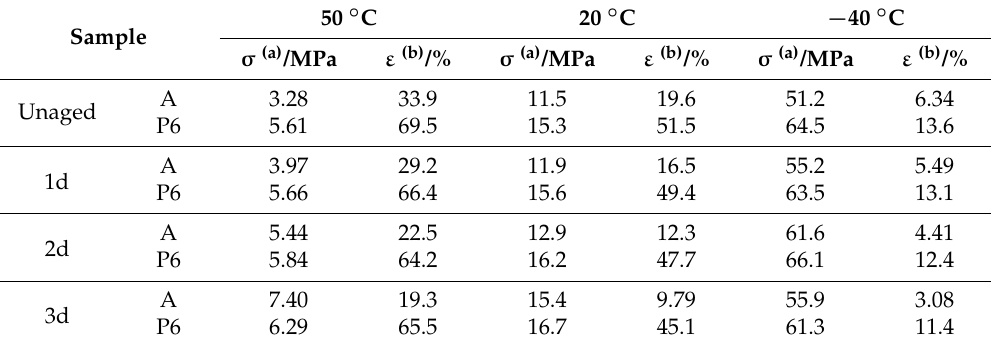
Figure 2. Tensile strength ( a ) and elongation at maximum tensile strength ( b ) of aged propellants. Table 1. Tensile properties of aged double base propellants.